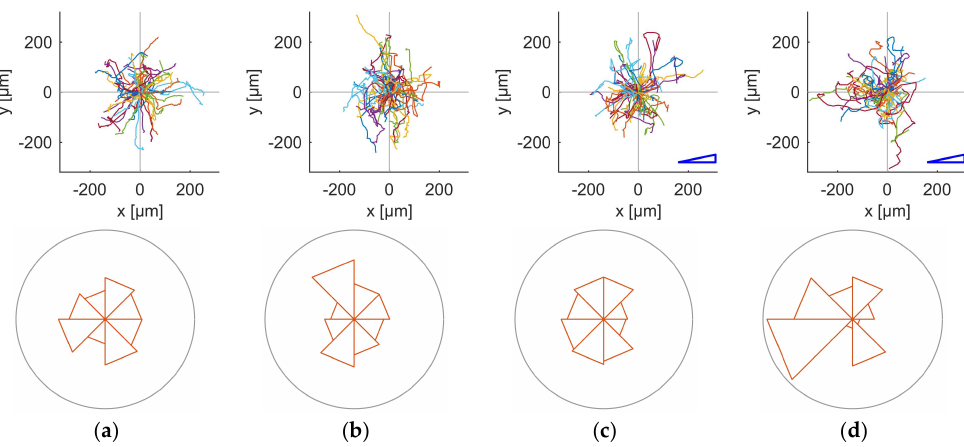
Figure 3. Representative migration tracks and weighted angular histograms of the final cell positions for the four different conditions. A blue triangle shows the direction of the oxygen gradient in the two gradient conditions. The starting points of the migration tracks of each cell are offset to (0,0). Each graph contains the data of all 50 tracked cells in a single experiment: ( a ) Normal MDA-MB-231 cells without gradient; ( b ) CSC enriched cells without gradient; ( c ) normal MDA-MB-231 cells in oxygen gradient; and ( d ) CSC enriched cells in oxygen gradient.